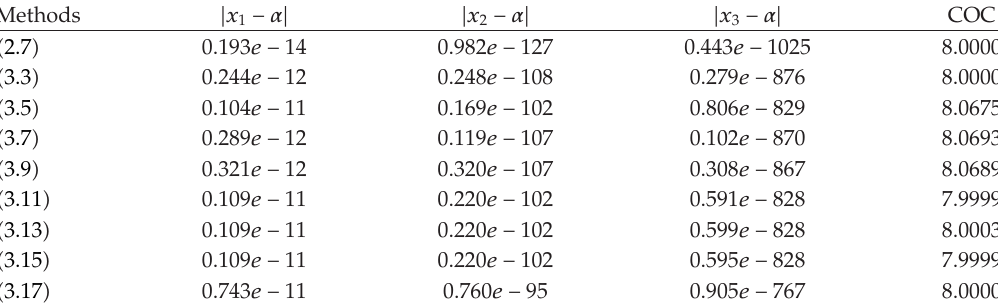
Table 2: Errors occurring in the estimates of the root of (cid:3) 4.2 (cid:4) by the methods described.